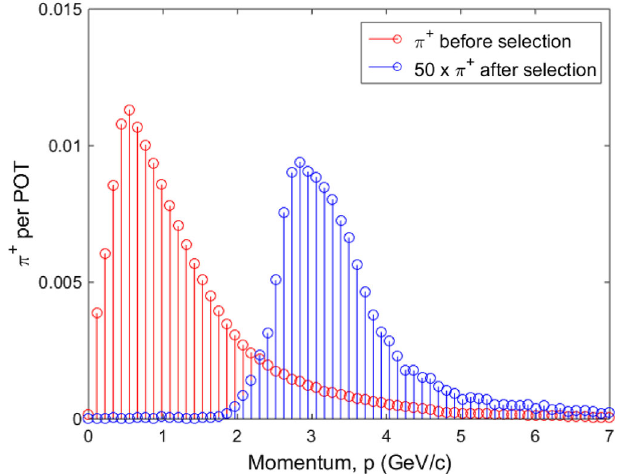
FIG. 5. Red: Momentum histogram of the pion beam a few millimeters after the target downstream edge. Blue: Momentum histogram downstream of the PMAG. The selection process is clearly shown. Note that the distribution shows a slight asym- metry, meaning that the largest population of secondary particles is concentrated at lower momenta. For visual purposes, the number of pions after the PMAG is multiplied by a factor of